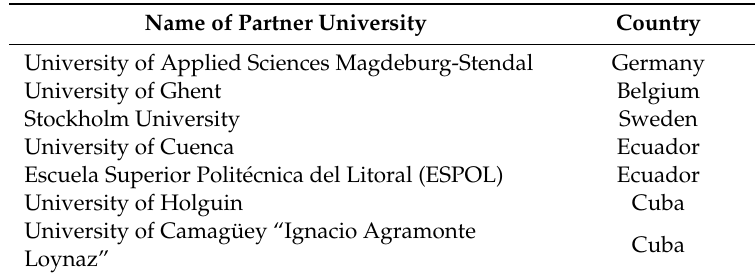
Table 1. Partners and countries included in the project Water Management and Climate Change in the Focus of International Master Programs